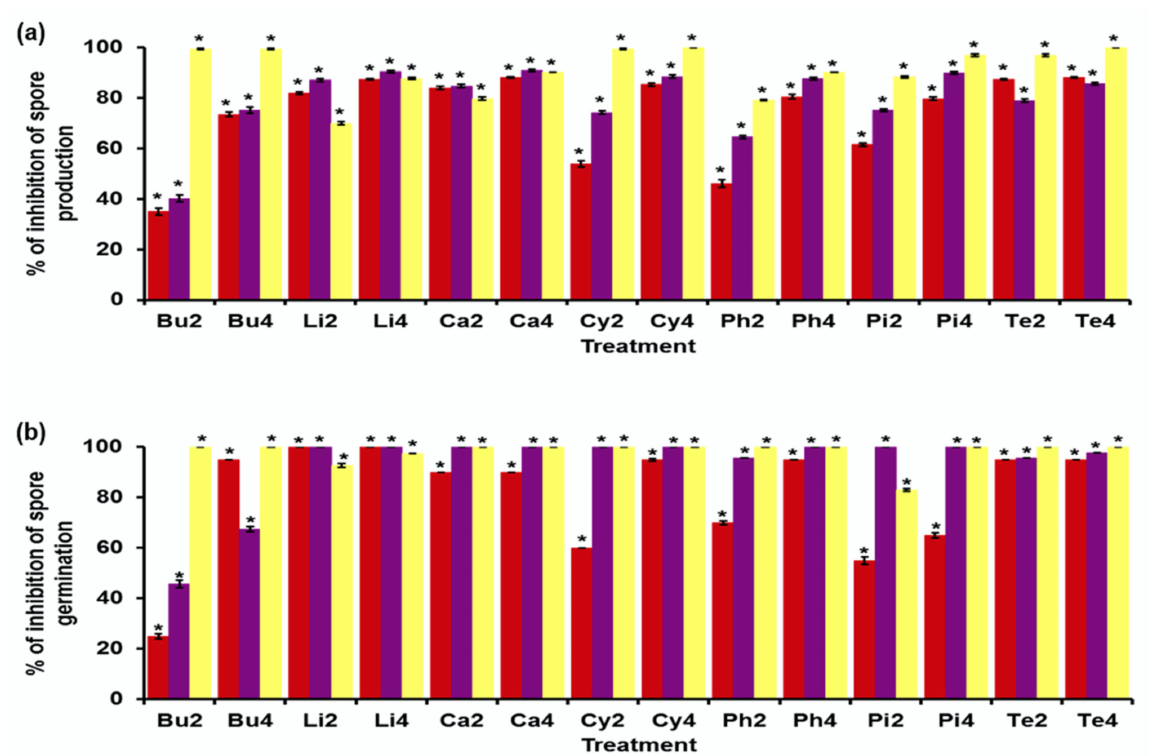
Figure 3. Effect of essential oils and five pure compounds on spore production and germination of three Fusarium strains. ( a ) Percentage of inhibition of spore production. ( b ) Percentage of inhibition of spore germination. Fusarium sporotrichioides (red), Fusarium moniliforme (purple), and Fusarium solani (yellow) exposed to Bursera morelensis essential oil (Bu), Lippia graveolens essential oil (Li), carvacrol (Ca), p -cymene (Cy), α -phellandrene (Ph), α -pinene (Pi), and Υ -terpinene (Te). The numbers corre- spond to the concentrations of 2.0 µ L/mL (2) and 4.0 µ L/mL (4). * Statistically significant values